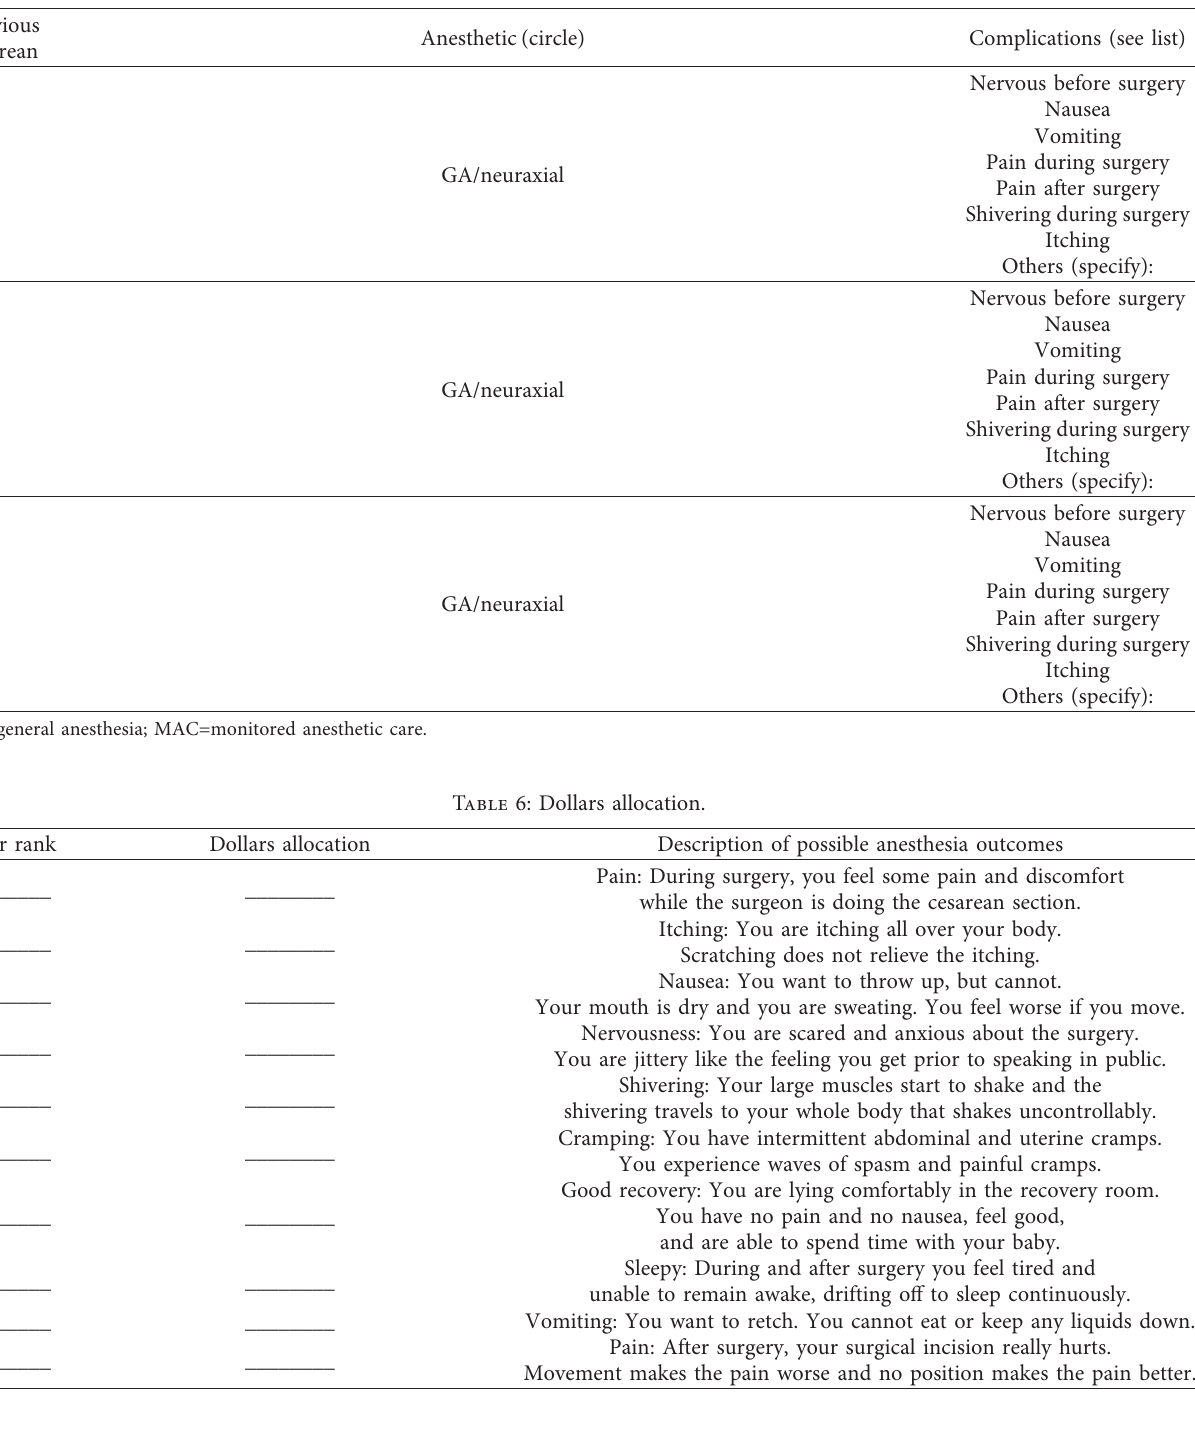
Table 7: Medication